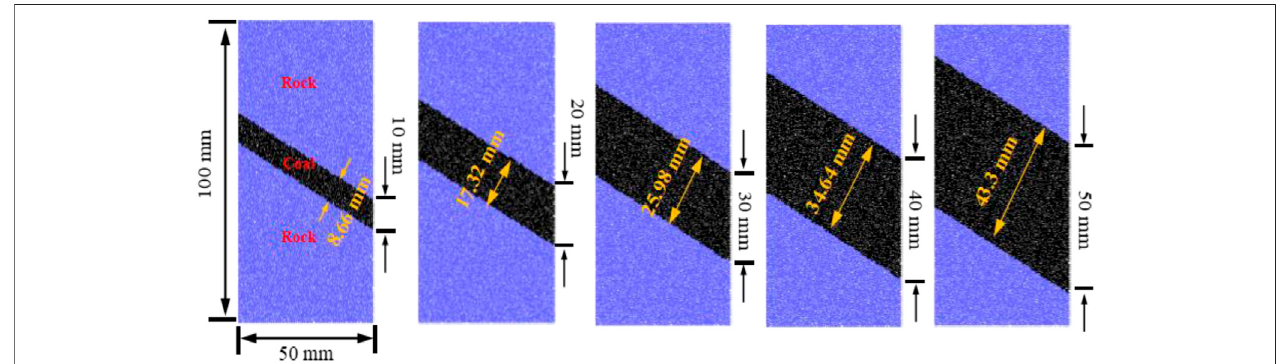
FIGURE 1 | Samples with different inclined coal seam thickness.